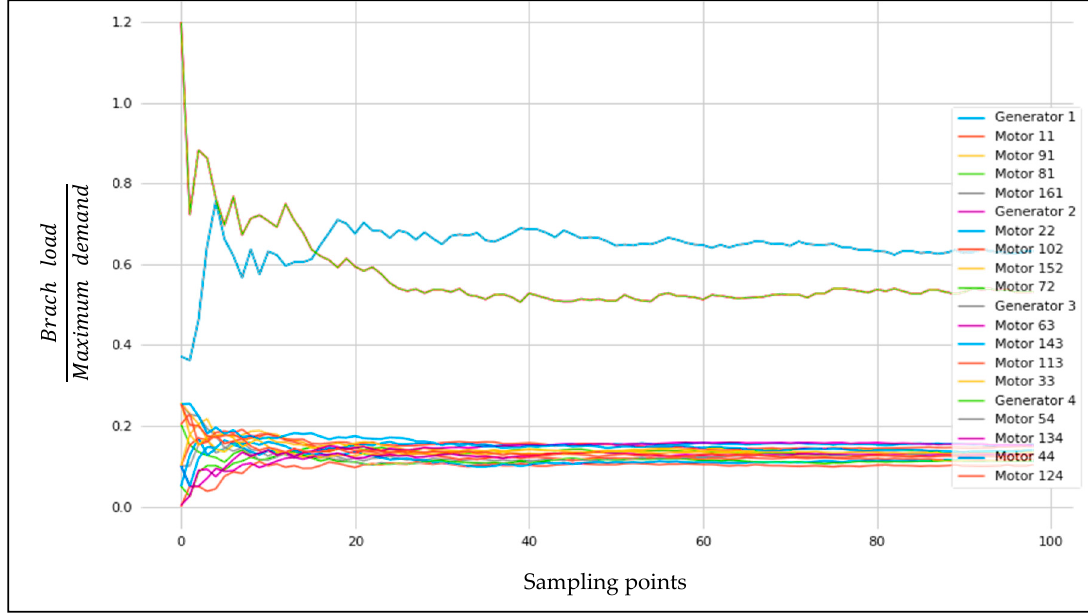
Figure 8. NASA N3-X RTO Monte Carlo branch loading average.